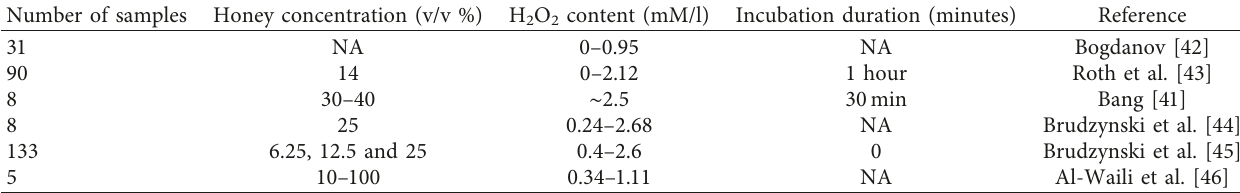
Table 2: Levels of hydrogen peroxide (H